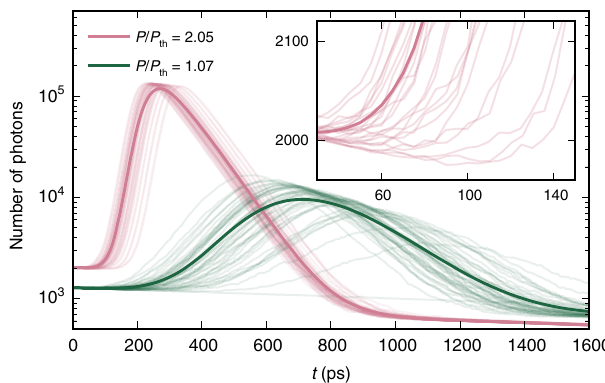
Fig. 7 Quantum trajectories simulation. Fifty individual trajectories are shown in light colours, while darker colours depict their (ensemble) average. The number of photons includes those from the single condensing mode as well as the spontaneous emission background discussed in “ Zero- time statistics ” . The parameters match those of Figs. 5 and 6. The inset depicts a zoomed view of the early stages of